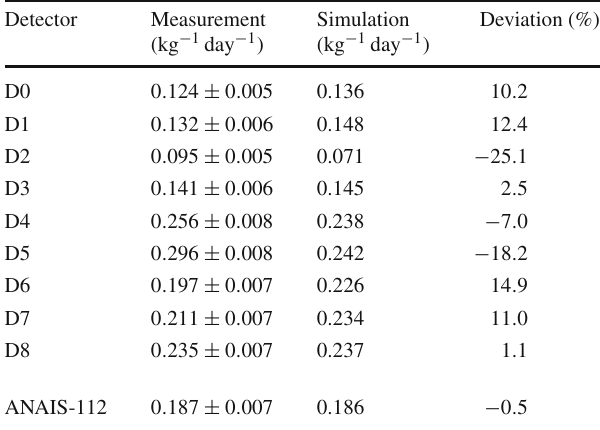
Table 7 Measured and simulated rates up to 2 keV from spectra shown in Fig. 5 and the corresponding deviation for each ANAIS-112 detector andonaverage.Thestatisticaluncertaintyofsimulatedrates(notshown in the table) is ∼ 0 .